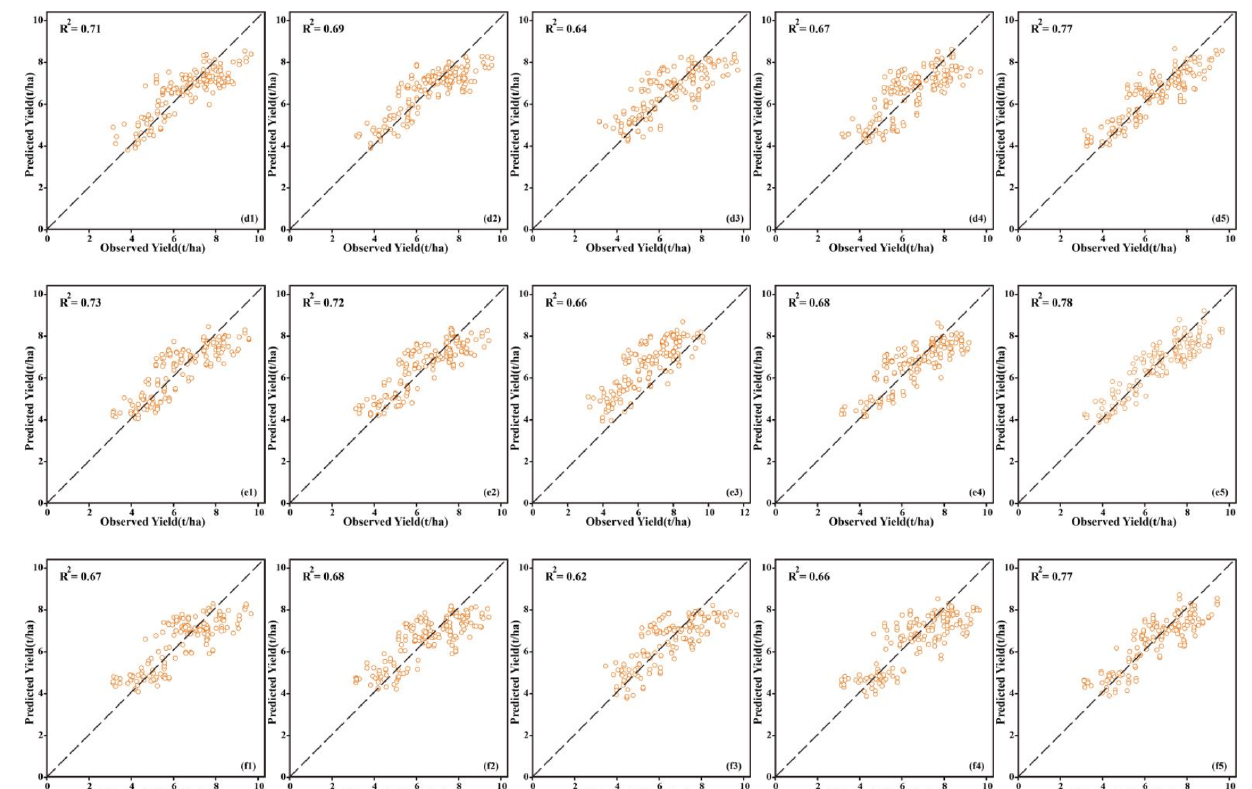
Figure A1. Scatter plots of observed versus predicted yields for the five models constructed from the three different feature selection methods. In the figure labels ( a1 – f5 ), the letters ( a , b , c ) indicate the RFE, Boruta, and PCC feature selection methods used at the flowering stage, respectively; ( d , e , f ) indicate the RFE, Boruta, and PCC feature selection methods used at the grain-filling stage, respectively; the numbers 1 – 5 indicate the SVM, GP, LRR, RF, and DLF